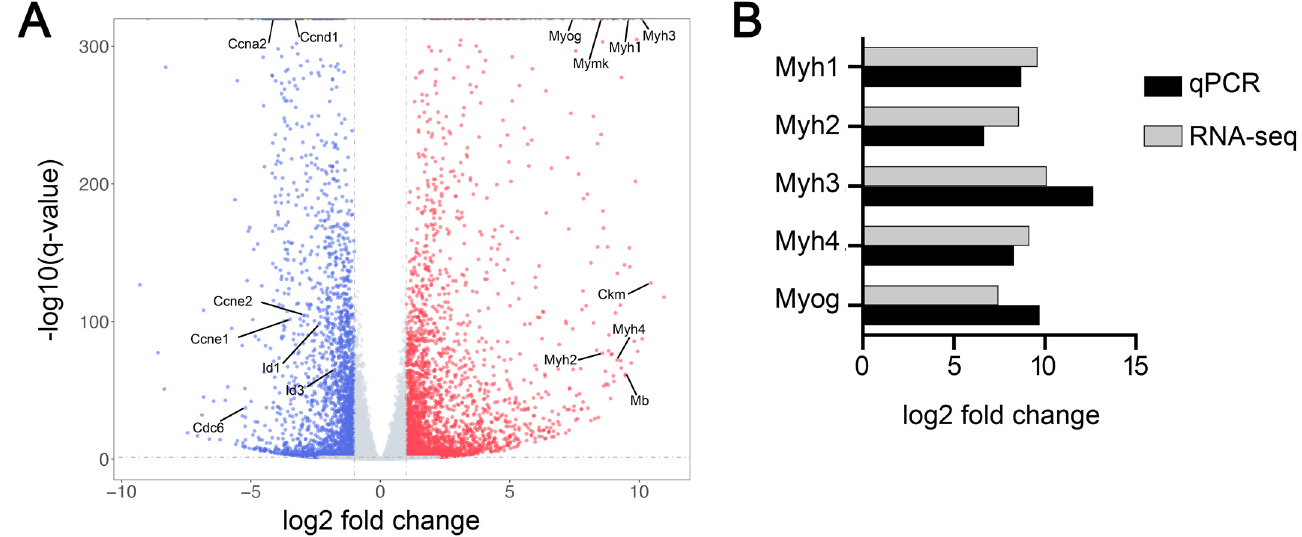
Figure 1. Identification of differentially expressed genes during myoblast differentiation. mRNA transcriptomes in C2C12 cells before ( n = 5) and 6 days after ( n = 5) induction of myogenic differen- tiation were analyzed by RNA-seq. ( A ) The overall distribution of differentially expressed genes ( P adj < 0.05). Genes upregulated and downregulated on day 6 of differentiation compared to before differentiation are indicated by red and blue dots, respectively. ( B ) Comparison of the fold changes in the expression of selected mRNAs determined by RNA-seq and RT-qPCR.